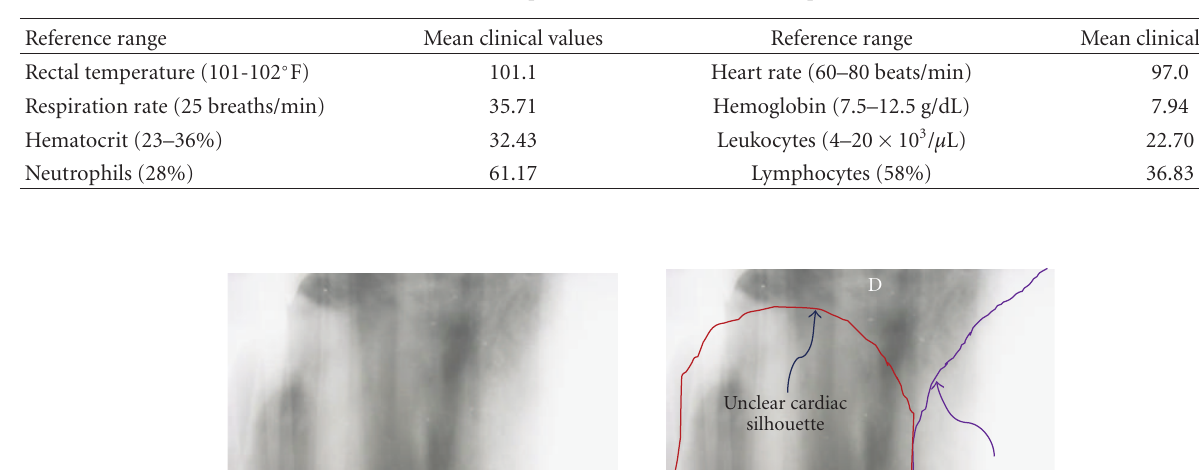
Table 1: Clinical parameters recorded in bovine pericarditis.